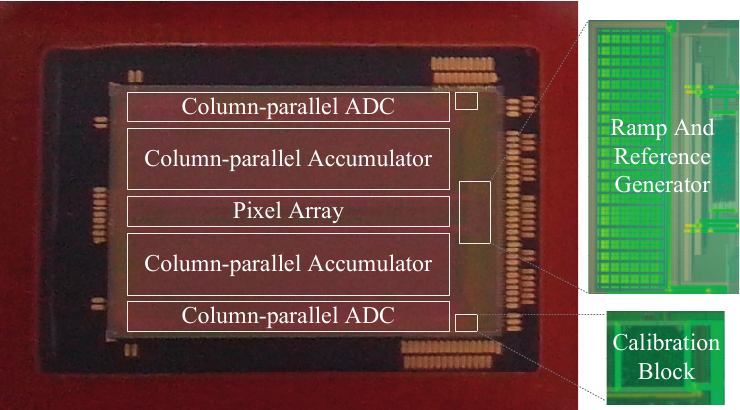
Figure 19. Photograph of the prototype image sensor and the chip partial